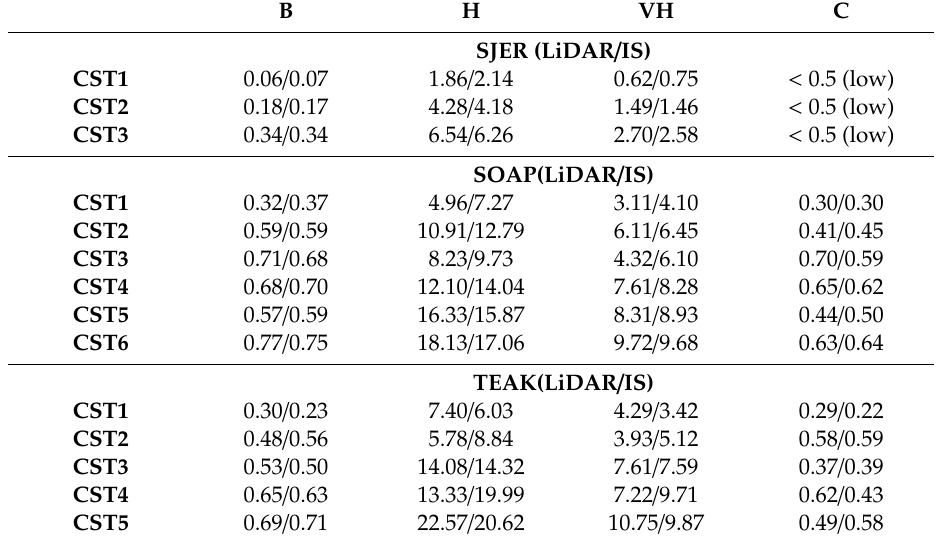
Table 4. Description of SJER, SOAP, and TEAK canopy structural types (CSTs) using LiDAR-derived variables and IS-derived variables. B: Biomass (from 0 to 1), H: Height (m), VH: Vegetation heterogeneity (m), and C: Clumping (from 0 to 1).